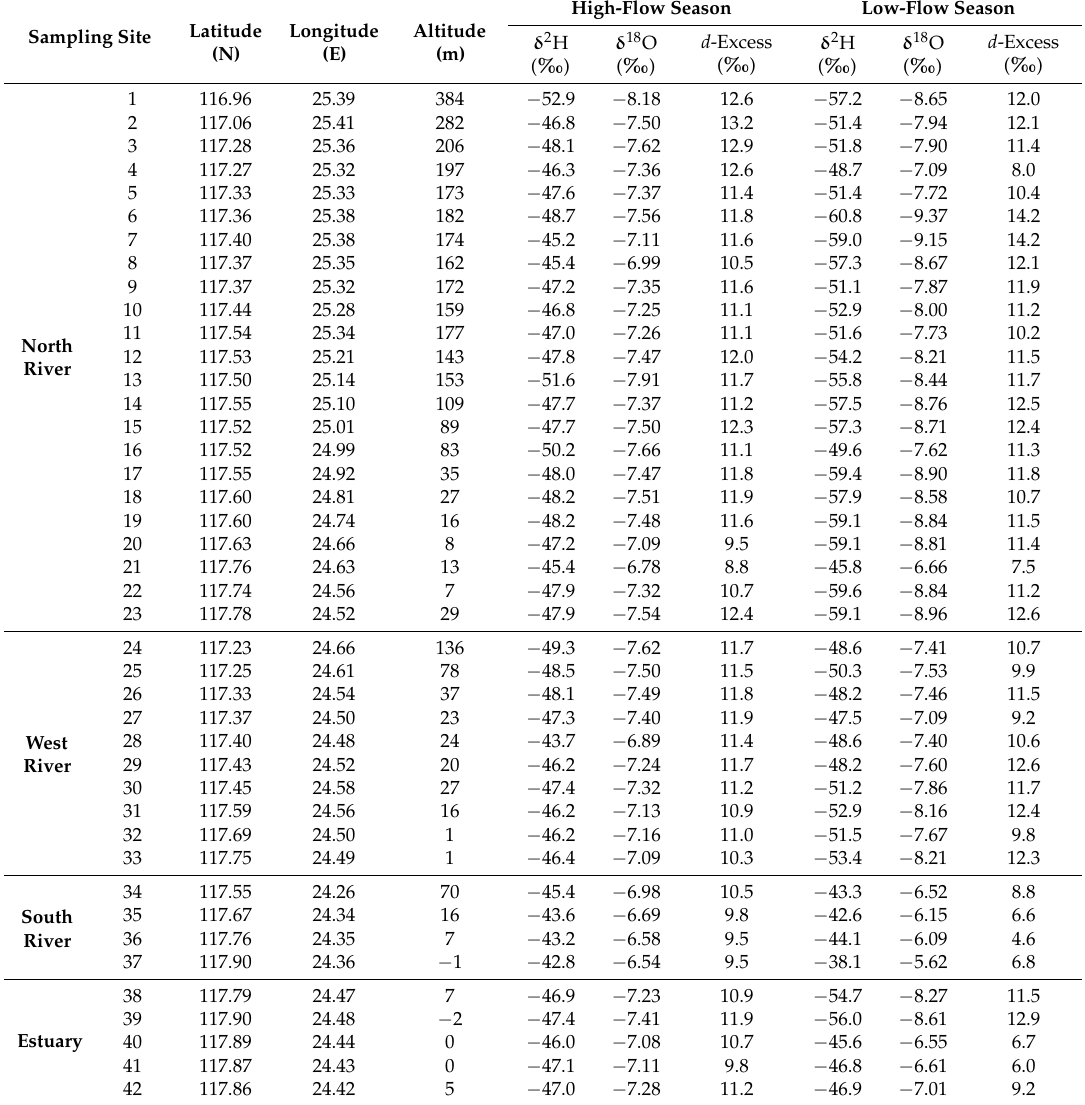
Table 1. Locations and isotope composition of the water samples in this study.